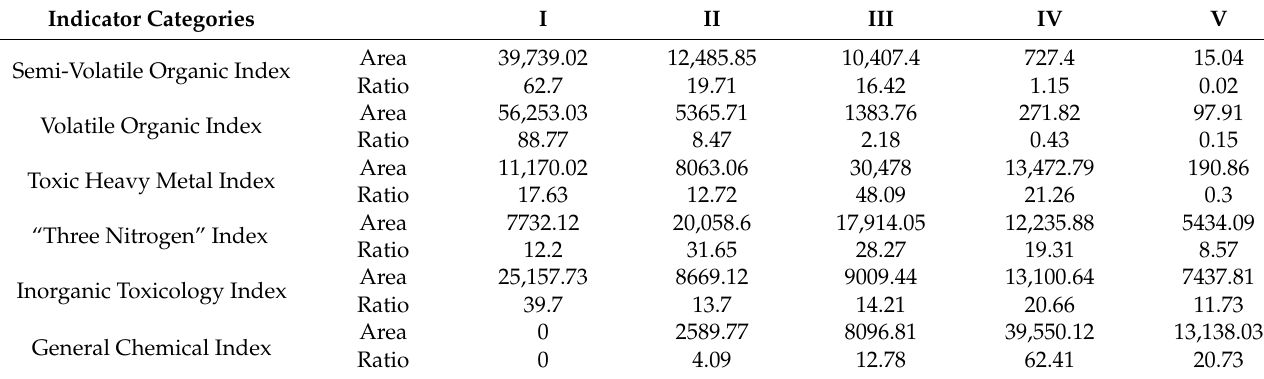
Figure 2. Map of multi-indicator evaluation. Table 4. Classification of multi-index evaluation.